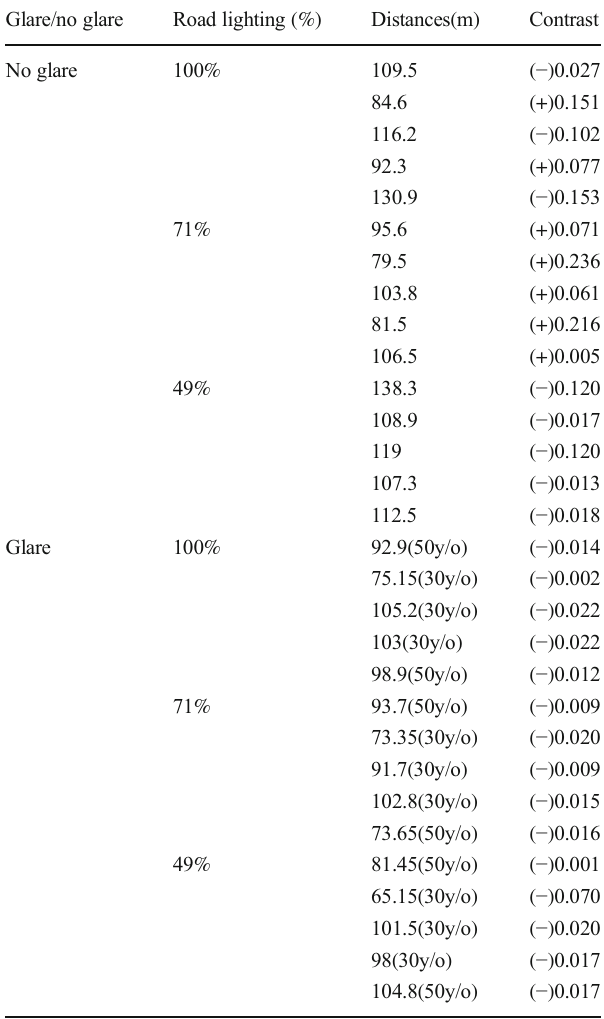
Table 3 Contrast in no glare/glare scenarios calculated for each detection distance (for glare scenario age factor is applied for each driver) Glare/no glare Road lighting